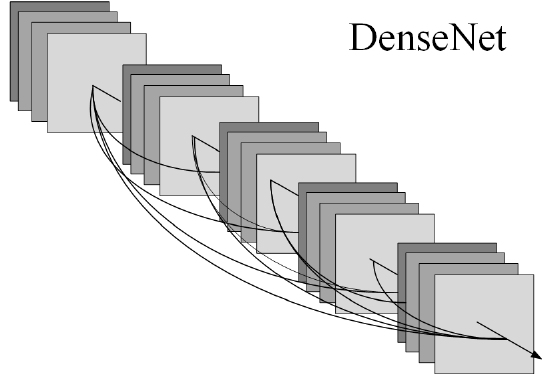
Figure 9. Residual block